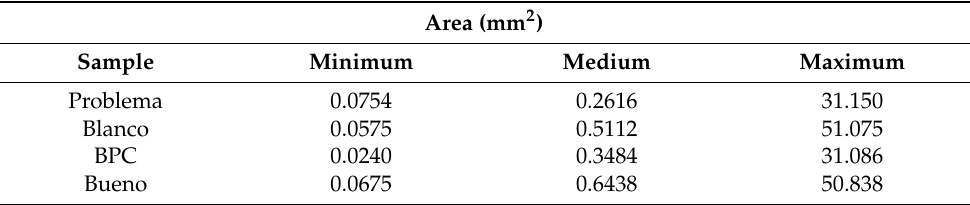
Figure 3. Histogram of particle number as a function of area in mm 2 . Table 1. Average particle size from SEM images at × 50 for KCl mineral sample.